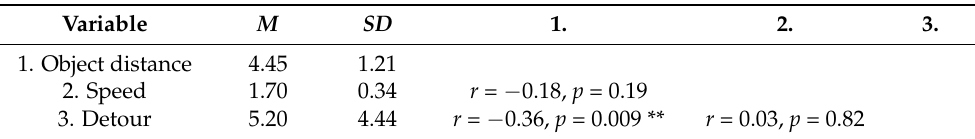
Table 2. Means, standard deviations, and correlations of the dependent variables of the repeated